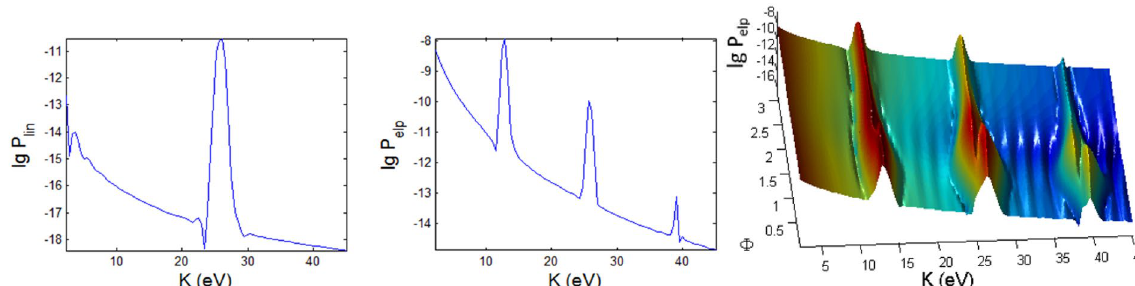
Figure 11. Same as Fig. 9 (versus angle Φ with t p = 10 fs) but for case